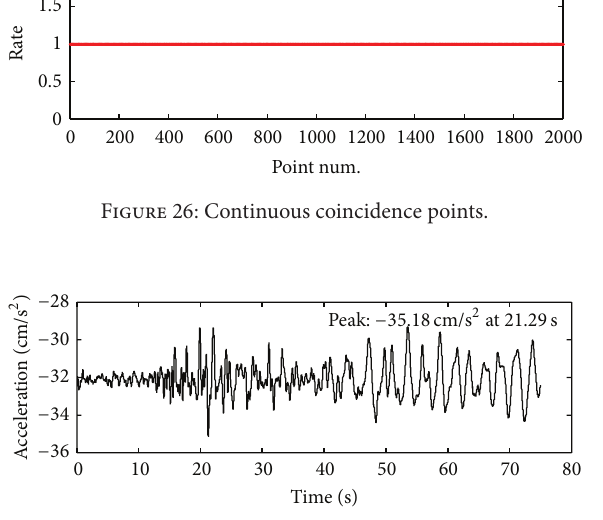
Figure 27: Acceleration time history (after